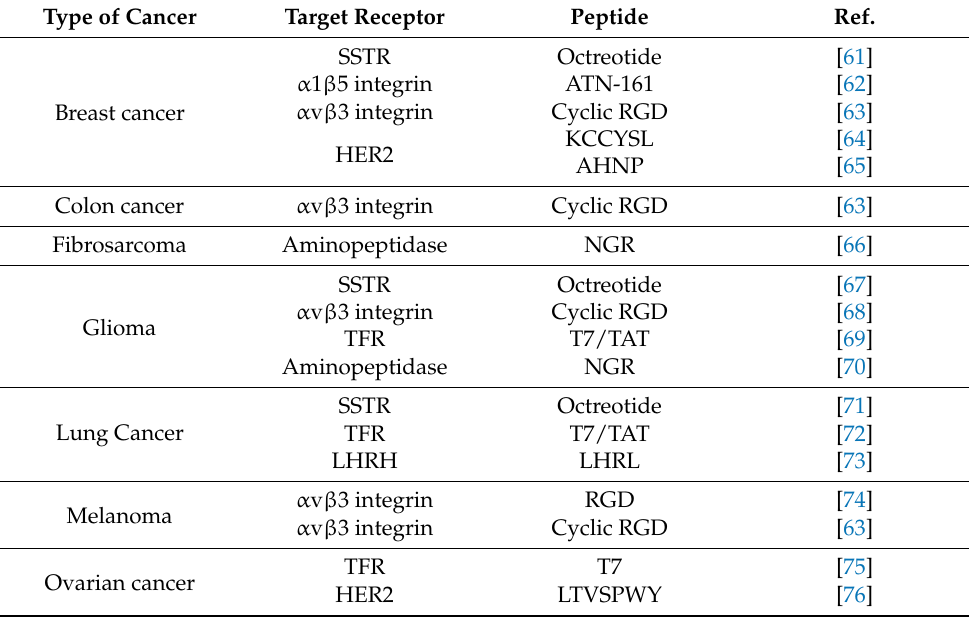
Table 1. Peptides used in conjugation with NDS for targeting cancer-specific